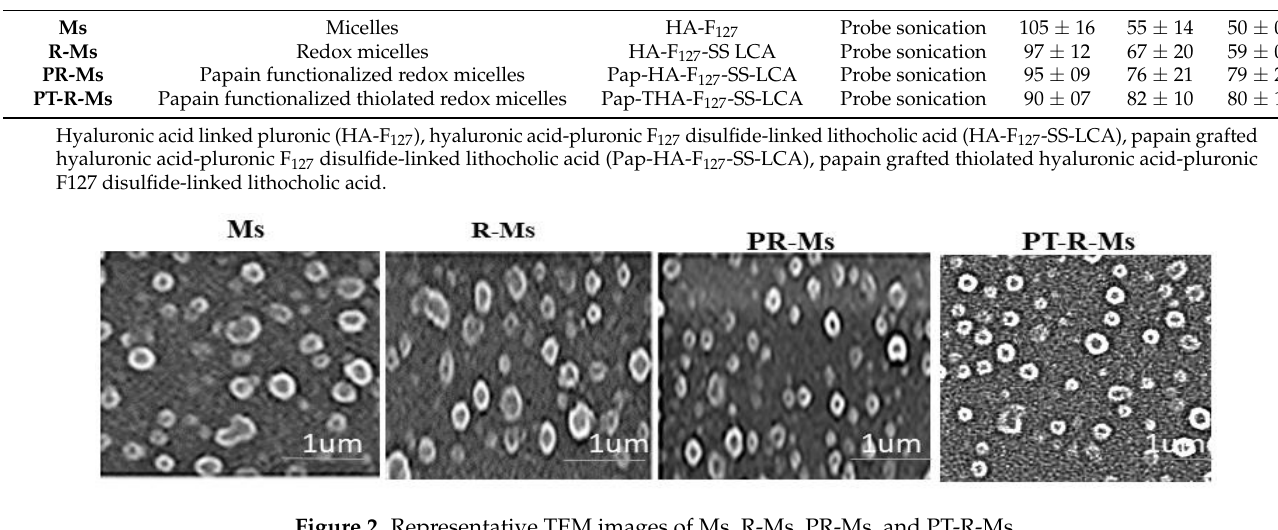
Figure 1. Gaussian particle size distribution obtained by DLS for ( A ) Ms and ( B ) PT-R-Ms. Data are expressed as mean ± SD ( n = 3). Table 1. Nomenclature, chemical composition, and characteristics of the different polymeric micelles used in this work. Formulation Code